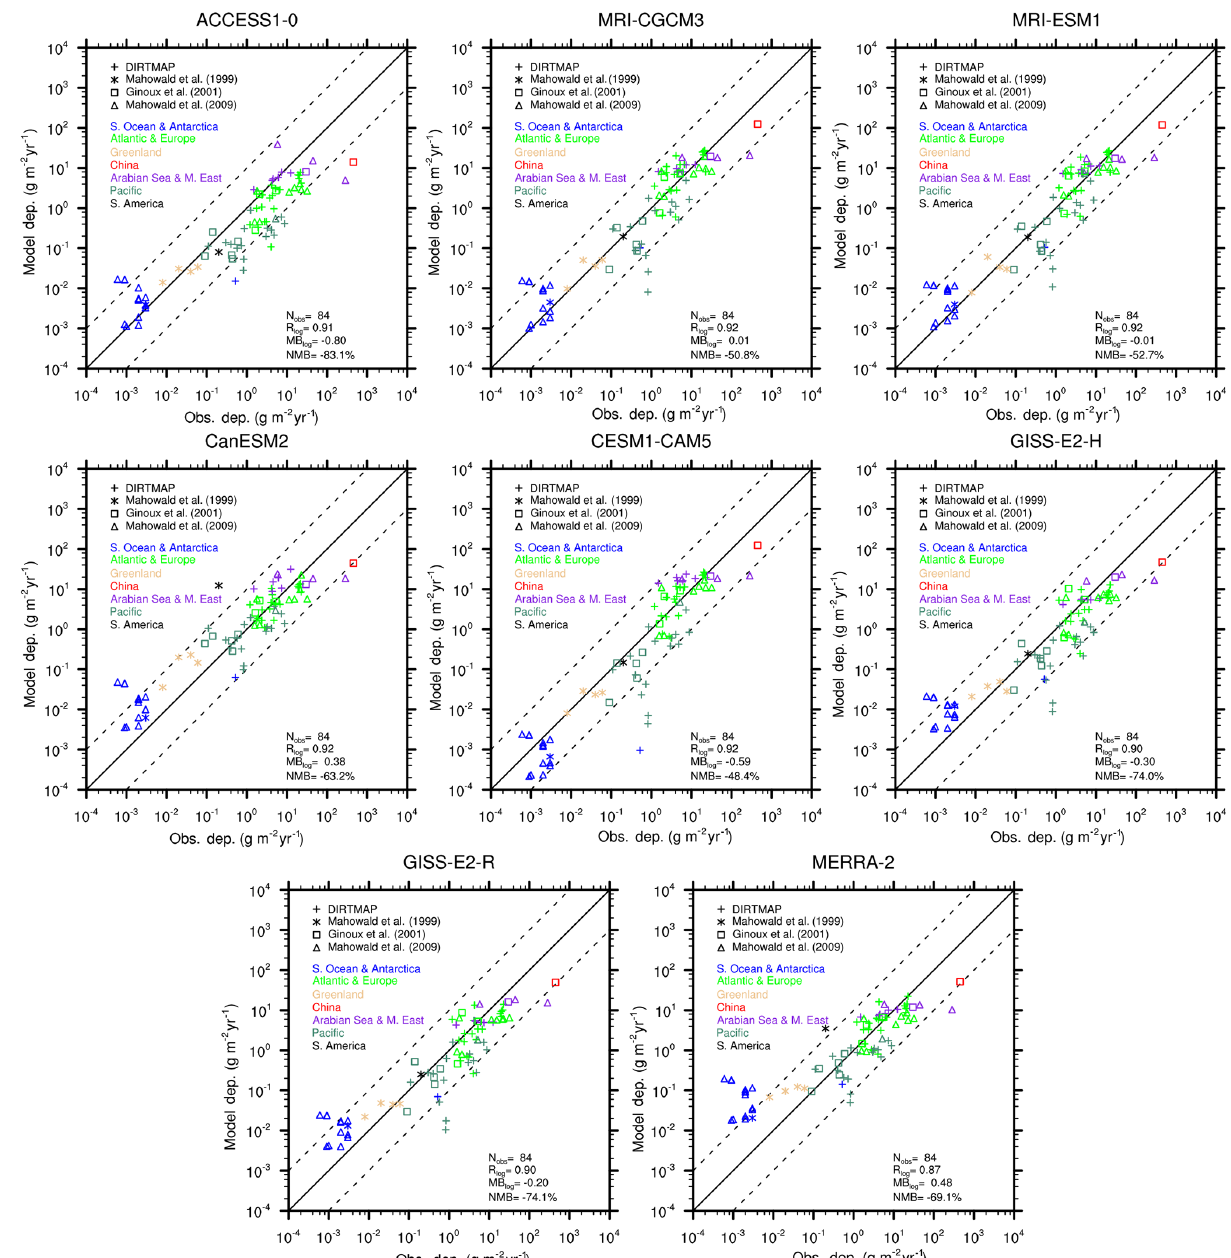
Figure 8. Scatter plot of dust deposition flux at 84 selected stations between models and observations. The stations are marked with different styles according to the sources of data and with different colours for different locations (Sect. 3.1). Also given are the correlation coefficients and mean bias between models and observations (after taking the logarithms; R log and MB log , respectively). The normalized mean bias (NMB) that is calculated from the mean bias divided by mean observations is given as well. The 1 : 1 (solid) and 1 : 10 / 10 : 1 (dashed) lines are plotted for